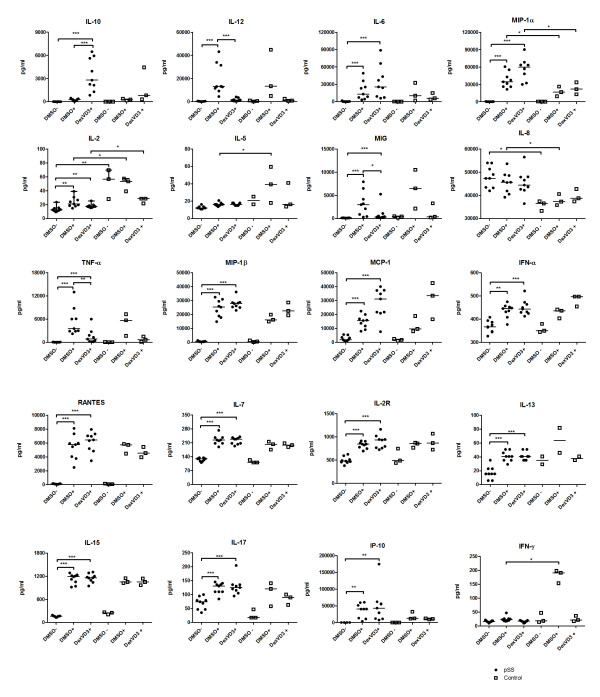
Cytokine profile of DexVD3 DC generated from patients with pSS. The cell-free supernatants were collected when harvesting the DC populations and stored in aliquots at -20°C until analysis. The amount of cytokines and chemokines secreted were analyzed using a 25-plex bead assay and the concentrations are given in pg/ml. Each symbol represents an independent sample, n = 9 for supernatants from DC from patients with pSS (filled circles) and n = 3 for supernatants from DC from healthy controls (open squares). GM-CSF and IL-4 were part of the added cytokines and therefore not included in the analysis. Cytokines and chemokines without significant differences between the groups (IL-1β, IL-1RA and Eotaxin) are not shown. The bars show the median and the differences between the secreted amounts of cytokines are marked with the following: *P ≤ 0.05; **P ≤ 0.01; ***P ≤ 0.001. DMSO-, immature DC; DMSO+, LPS-stimulated DC; DexVD3+, LPS-stimulated DC generated in the presence of dexamethasone and 1alpha,25-dihydroxyvitamin D3; GM-CSF, granulocyte-macrophage colony-stimulating factor; pSS, primary Sjögren's syndrome.